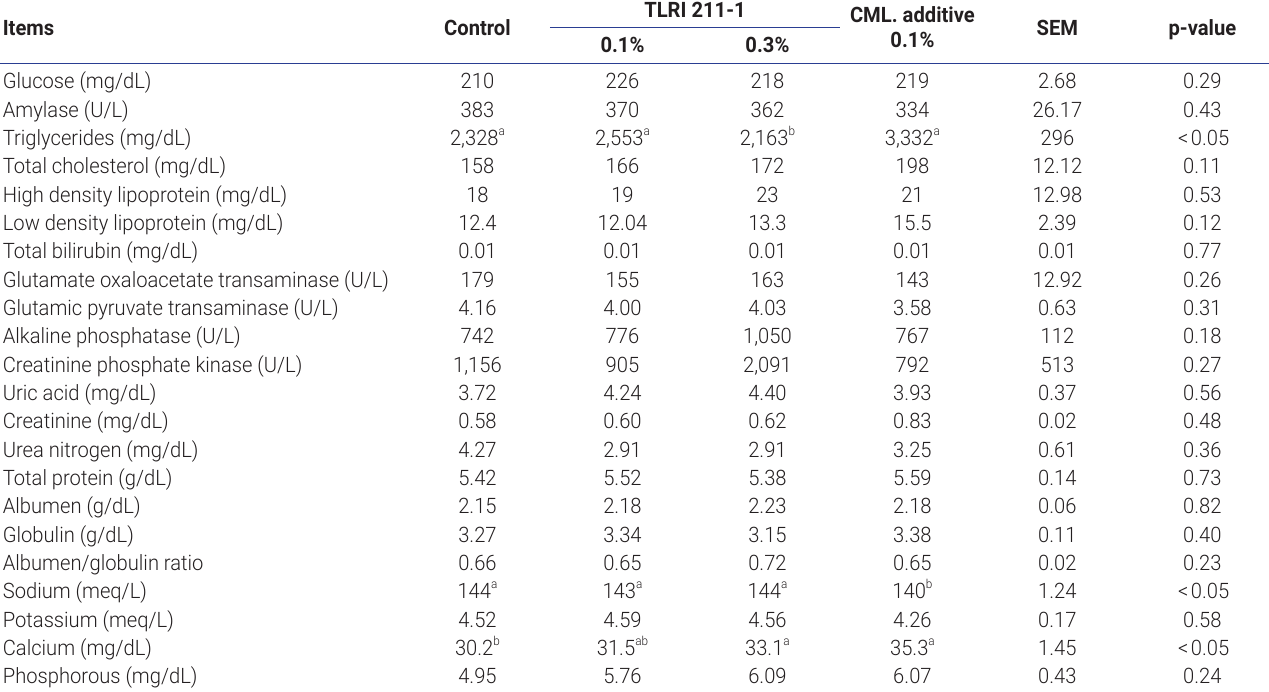
Table 6. Effects of dietary supplementation of Bacillus subtillis and B. amyloliquefaciens on blood characteristics of Leghorn laying hens 1)